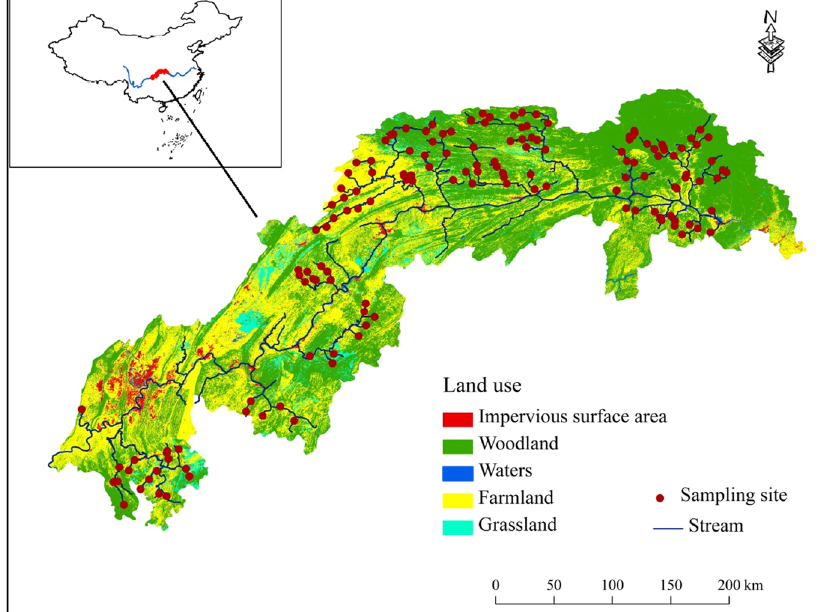
Figure 1. Location of the sampling sites and land use patterns in the Three Gorges Reservoir region. The map was generated using ArcGIS 10.0 (ESRI, Redlands, CA, USA: